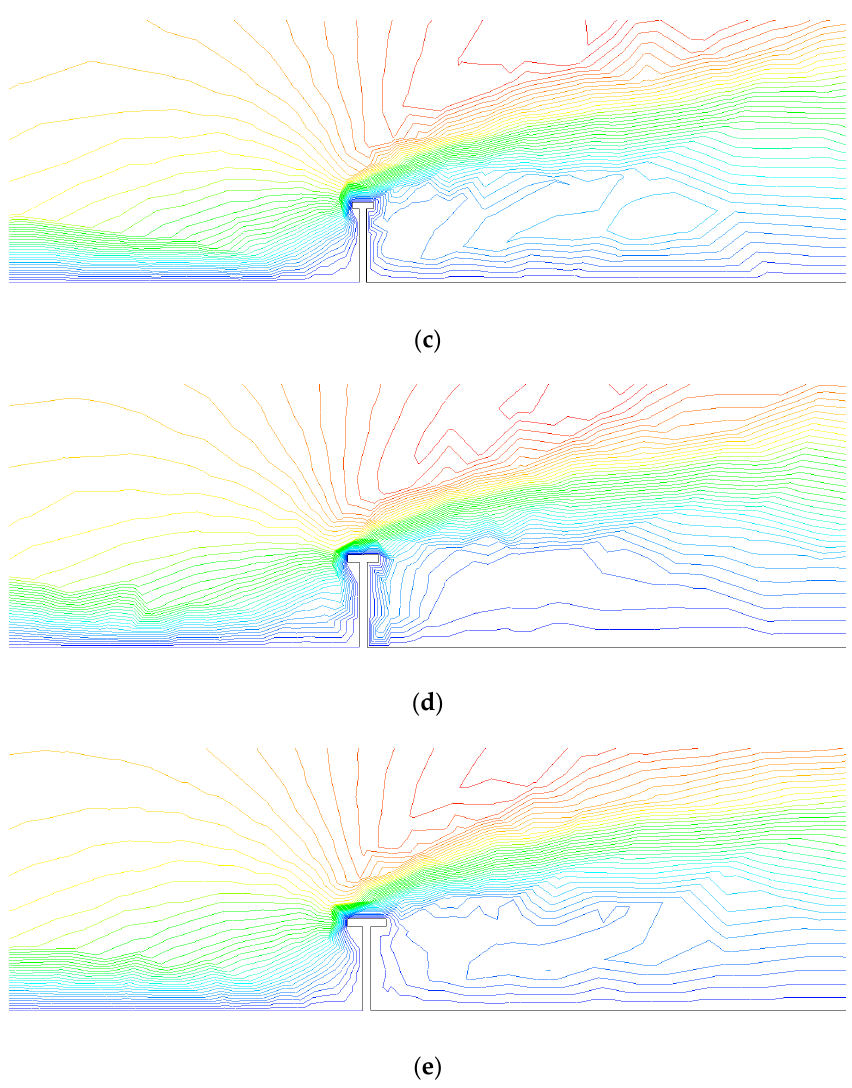
Figure 22. Wind velocity streamline on symmetry. ( a ) Base case; ( b ) case 1; ( c ) case 2; ( d ) case 3; ( e ) case 4.